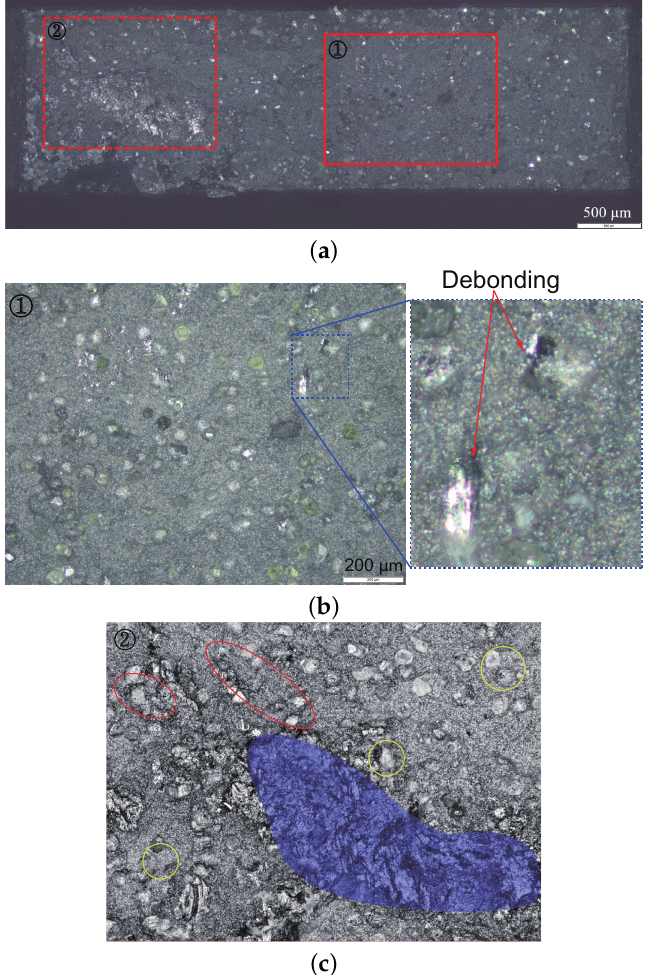
Figure 5. Fracture surface (type-II quasi-brittle behavior): ( a ) the whole fracture surface, where the rectangles in solid and dashed lines are shown in ( b , c ) at higher magnifications, respectively; ( b ) zoomed-in view with more recognizable diamonds; ( c ) zoomed-in view, where clusters of dia- mond particles amount to about 12 vol.% (5 vol.% in